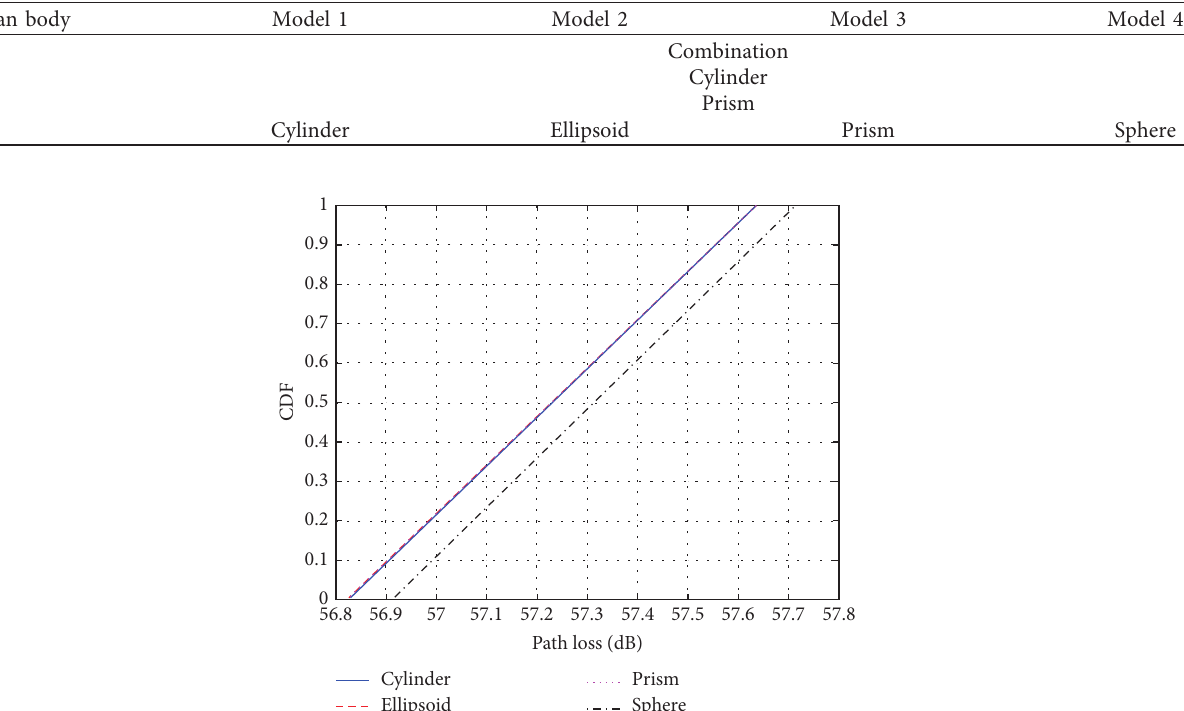
Table 9: Human body models with various head shapes.